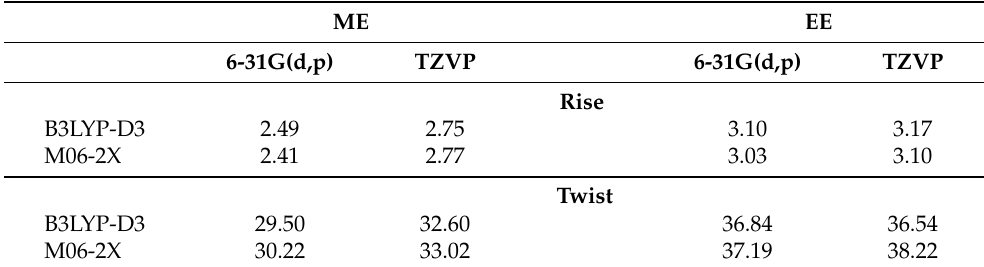
Table 3. Average rise (Å) and twist (degrees) of ss-C 4 predicted by different ONIOM geometry optimizations.